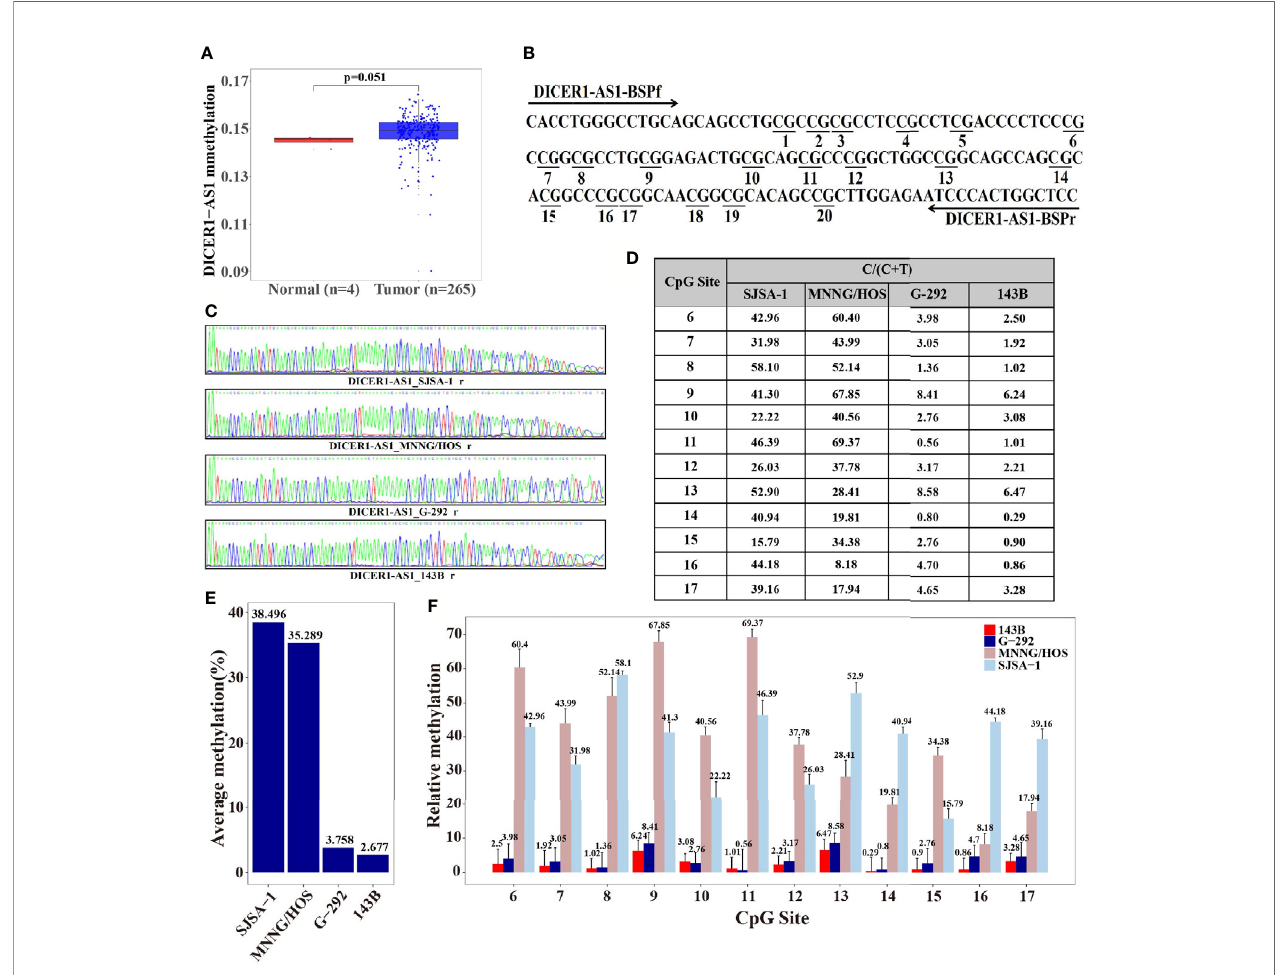
FIGURE 2 | Differential methylation of the DICER1-AS1 gene in SJSA-1, MNNG/HOS, G-292 and 143B cells. (A) The methylation of DICER1-AS1was upregulated in tumor (TCGA data, red dot for tumor tissue, n=265; blue dot for normal tissue, n=4). (B) The CpG dinucleotides and the BSP primers of the DICER1-AS1 gene are shown. (C) The original reverse sequencing results of the bisul fi te-converted DNA of the four OS cells are shown. (D – F) The percentage of CpG methylation of the four OS cells was summarized in the